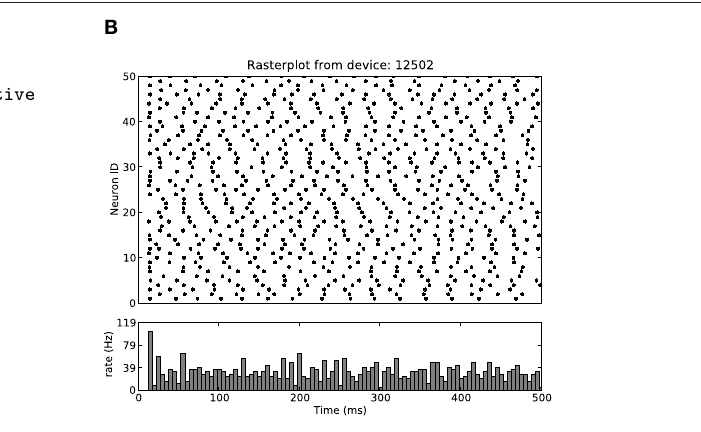
the summary printed at the end of the simulation. (B) Spike raster (top) and spike time histogram (bottom) of the N_rec recorded excitatory